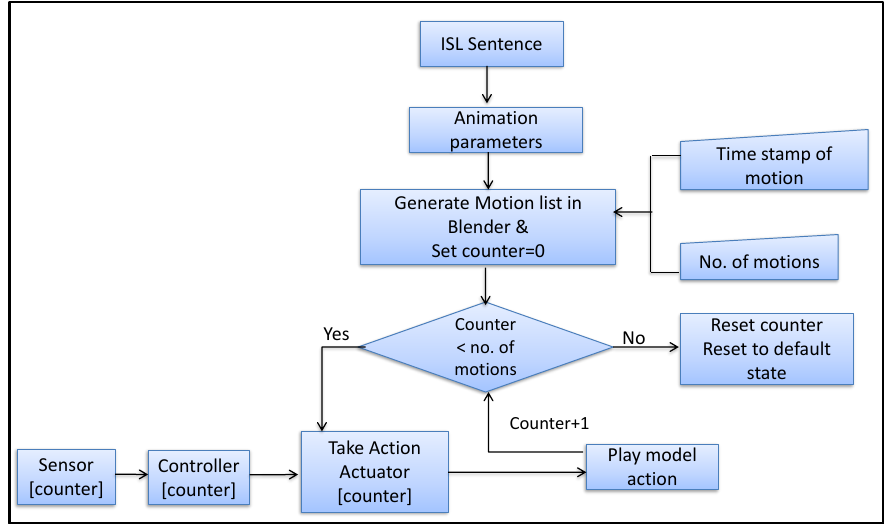
Figure 5. Movement generation of avatar from ISL sentence.